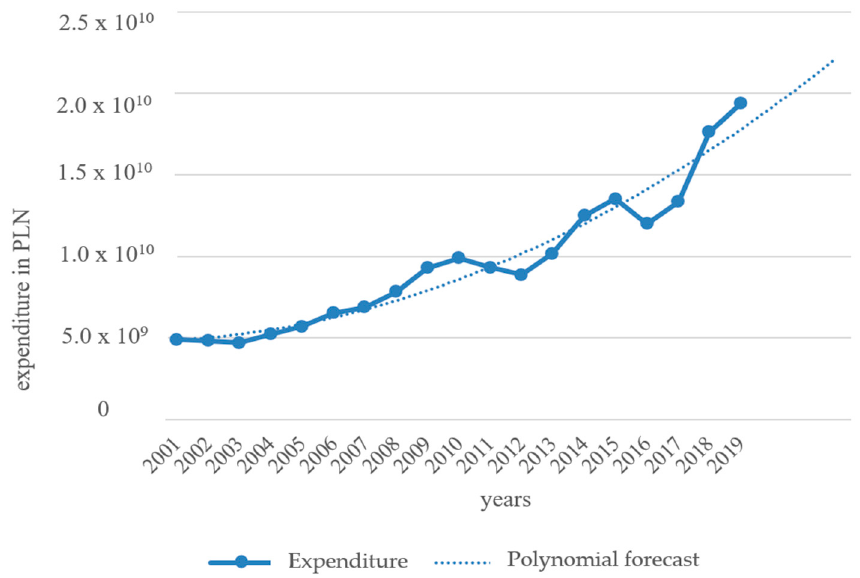
Figure 5. Expenditure on street lighting for municipalities in Poland. Source: [48].